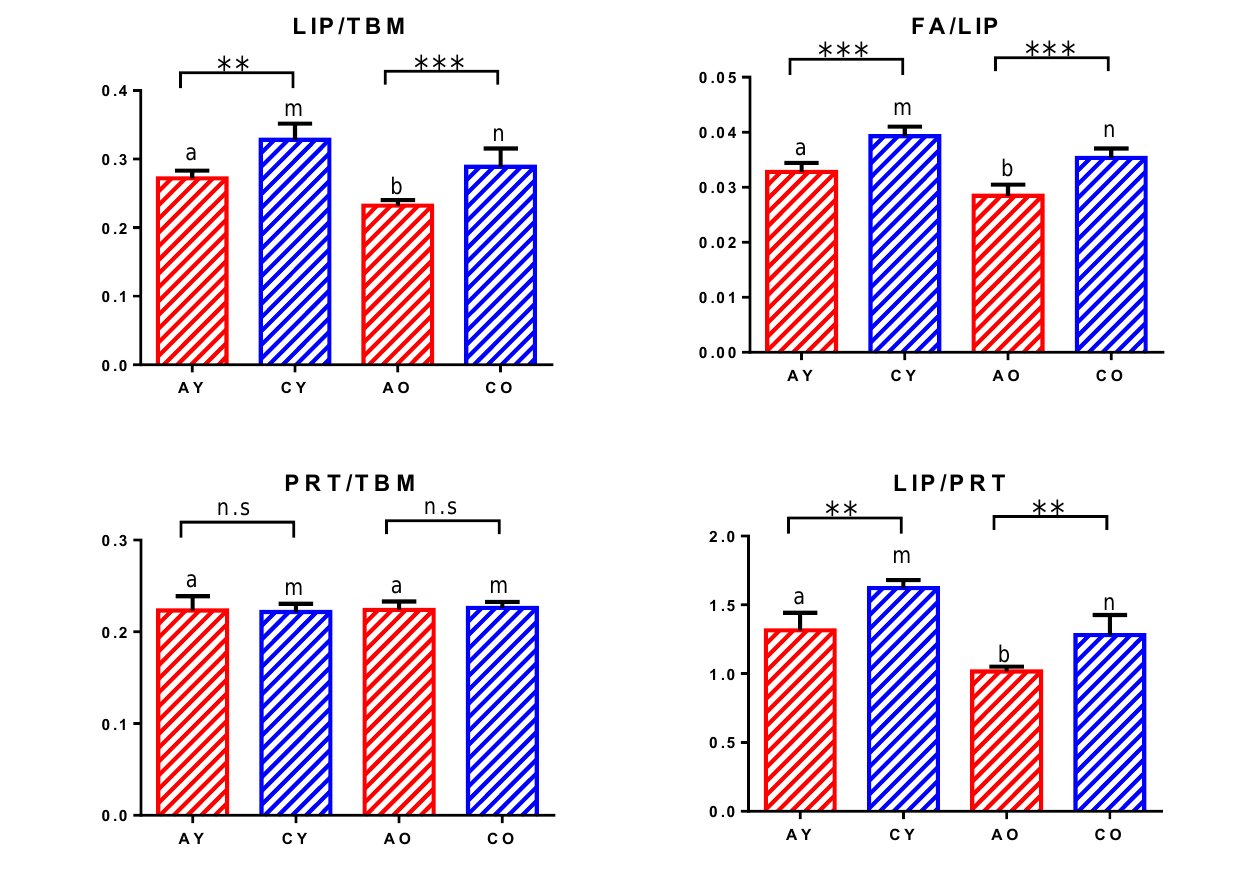
Figure 4. Statistical analysis of the macromolecular composition of A and C regions of Young and Old CC samples: LIP/TBM (total amount of lipids); FA/LIP (relative amount of fatty acids to lipids); PRT/TBM (total amount of proteins), and LIP/PRT (relative amount of lipids to proteins). Asterisks indicate statistically significant differences between A and C regions within the same group (n.s., p > 0.05; ** p < 0.01; *** p < 0.001). Different lowercase letters over histograms were used to indicate